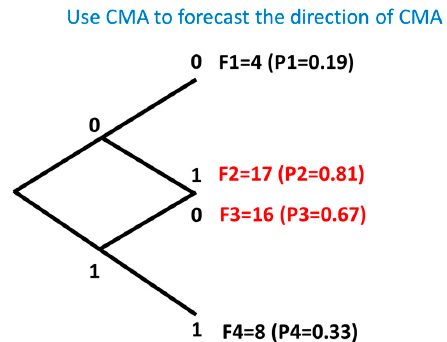
Figure A10. Use RMW to forecast the direction of RMW.